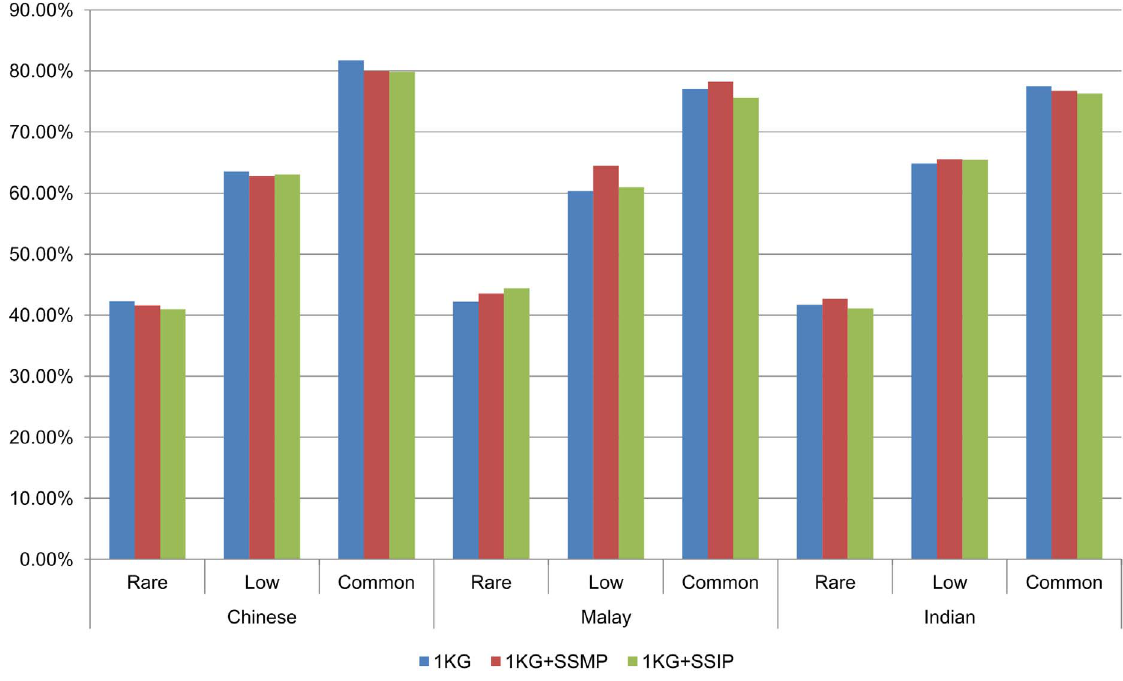
Figure 2. The percentage of polymorphic exome chip SNPs in each of the three populations that can be reliably imputed against three different reference panels using the SNPs on the Illumina HumanOmni2.5 as input. Each of these SNPs is categorized according to the minor allele frequency (MAF) as rare (0% , MAF # 1%), low-frequency (1% , MAF # 5%) and common (MAF . 5%). See Figures S1 and S2 in the Supplementary Material for the equivalent figures when SNPs on the HumanHap550 and Human1M are used as input respectively. The total number of imputed exome SNPs when using Illumina HumanOmni2.5/HumanHap550/Human1M as the study panel is shown in Table S4, S5 and S6.